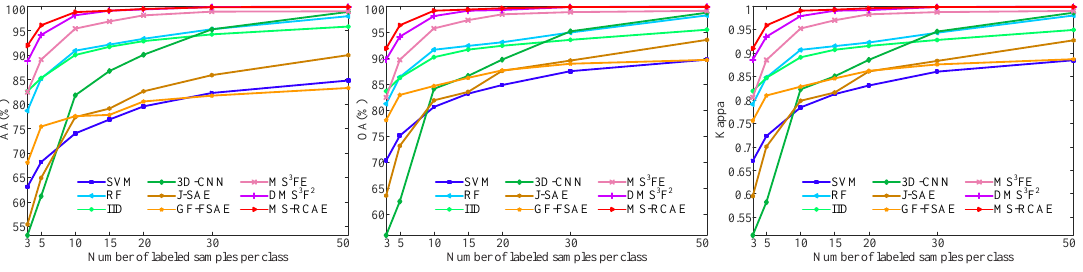
Figure 15. Effect of the number of training samples on classification accuracy for the KSC